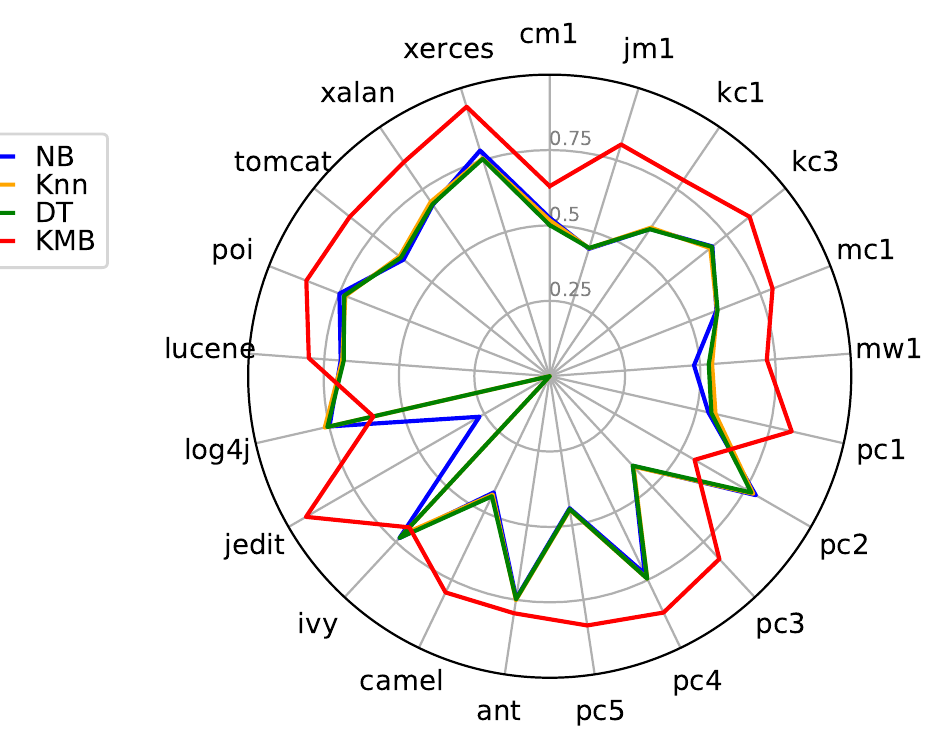
Figure 7. G-mean for the basic classifiers and